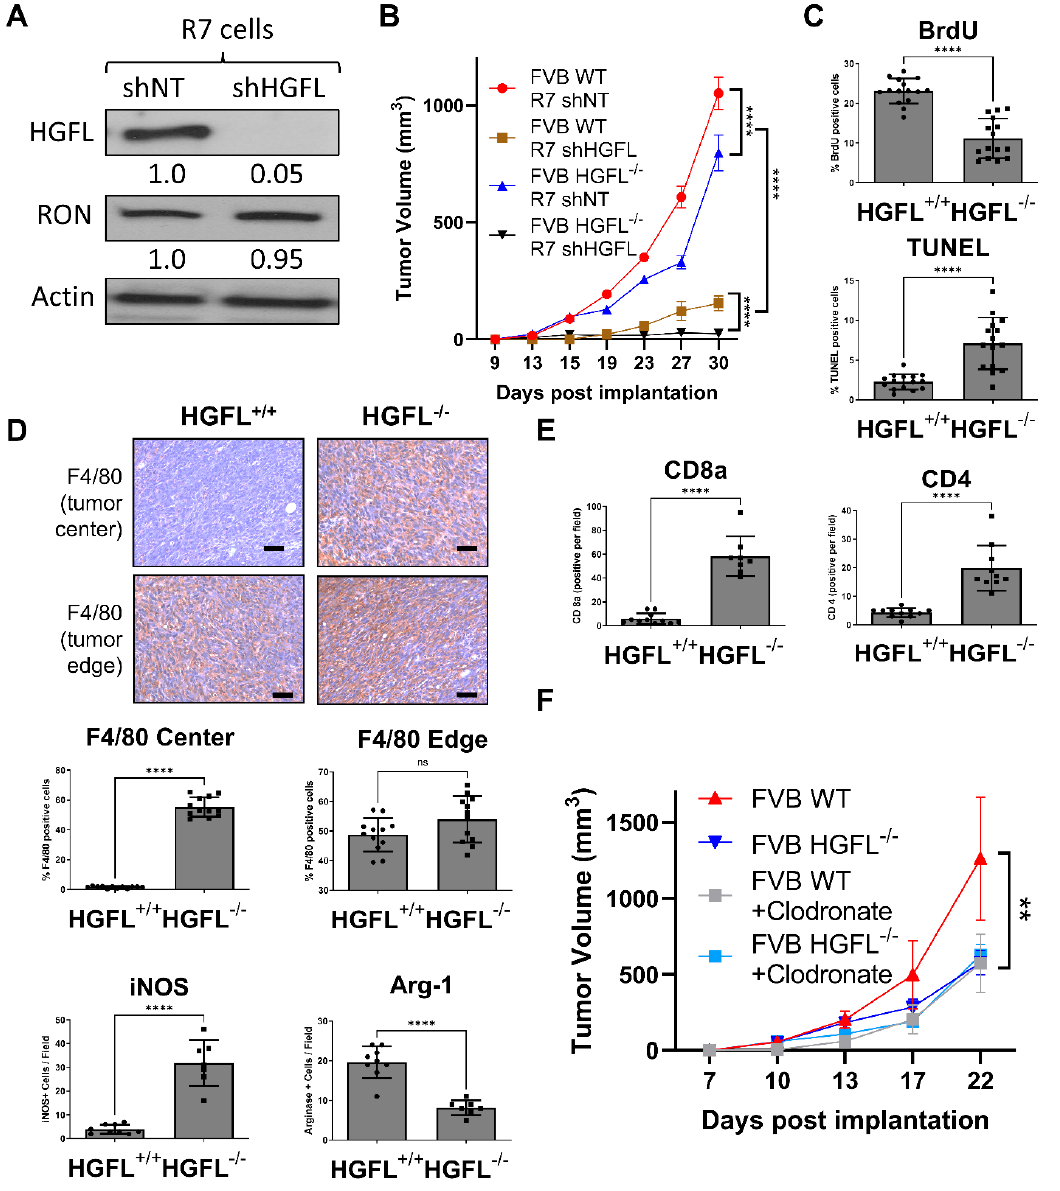
Figure 3. Loss of tumor cell-produced HGFL or systemic (physiologic) HGFL alters mammary tu- morigenesis and immune cell recruitment. ( A ) Western blot analysis of lysates from R7 shNT and R7 shHGFL cells for HGFL and Actin (loading control). ( B ) Mammary tumor growth kinetics of R7 shNT and R7 shHGFL cells following orthotopic implantation into syngeneic HGFL deficient (FVB HGFL − / − ) or HGFL proficient FVB (FVB WT; HGFL +/+ ) mice (n = 5 mice/group) and results were compared with a repeated-measures two-way ANOVA with Holm-Šídák post hoc tests. ( C ) Tumor characterization through histological analyses for Ki67, CC3, ( D ) F4/80, iNOS, Arginase-1, and ( E ) CD8a and CD4. ( F ) Tumor growth kinetics of mammary tumors generated from R7 cells in either WT or HGFL − / − mice with or without liposomal clodronate treatment to deplete macrophages (n = 6 mice/group). Groups were compared using a two-way ANOVA with Holm-Šídák post hoc tests. ** p < 0.01; **** p < 0.0001; ns, not significant. To determine the functional contribution of macrophages in the context of HGFL, we examined the growth of orthotopically transplanted R7 control cells into WT or HGFL +/+ mice and treated the mice with or without clodronate to deplete macrophages (Figure